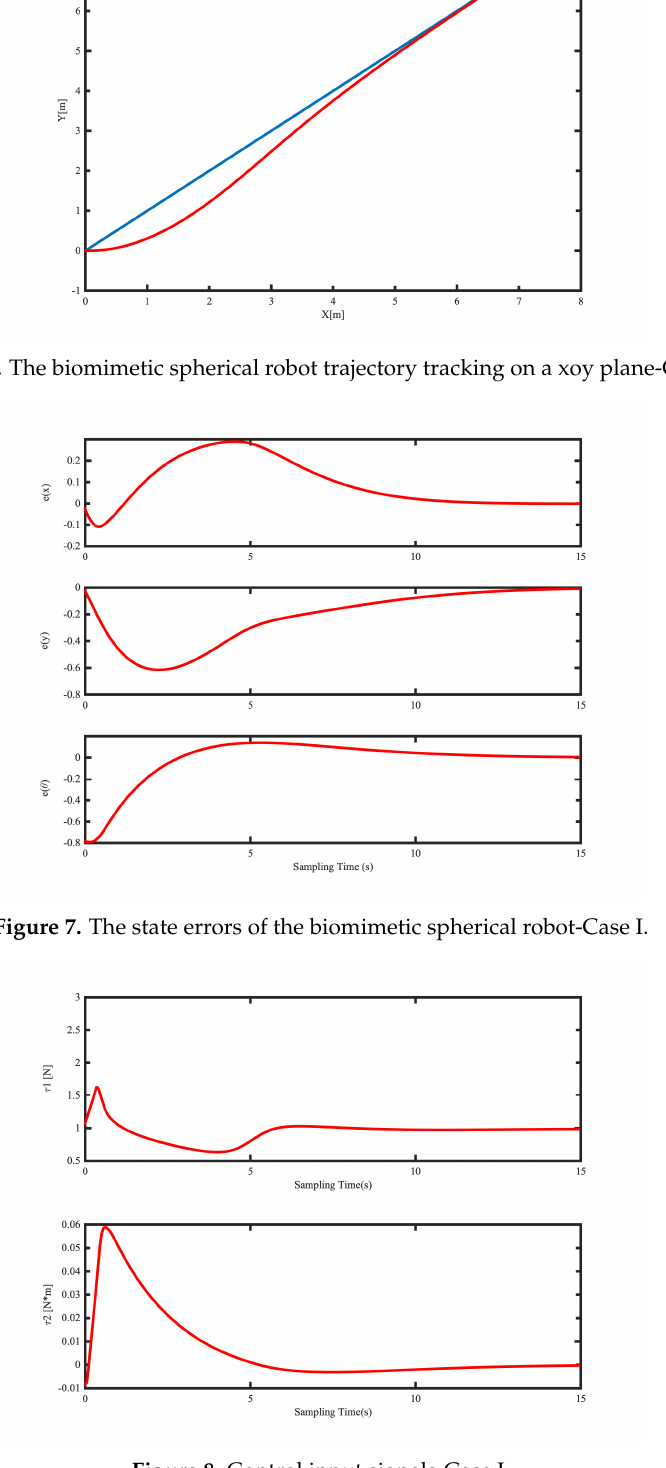
Figure 8. Control input signals-Case